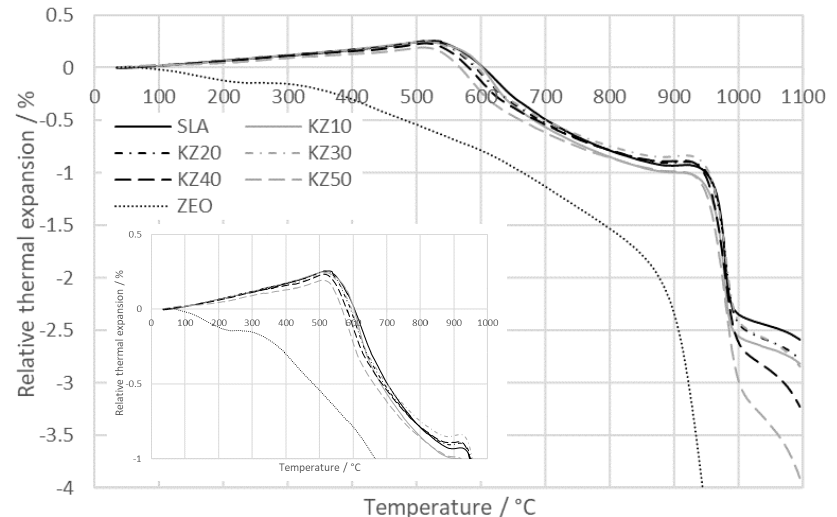
Figure 6. Relative thermal expansion of the studied samples.